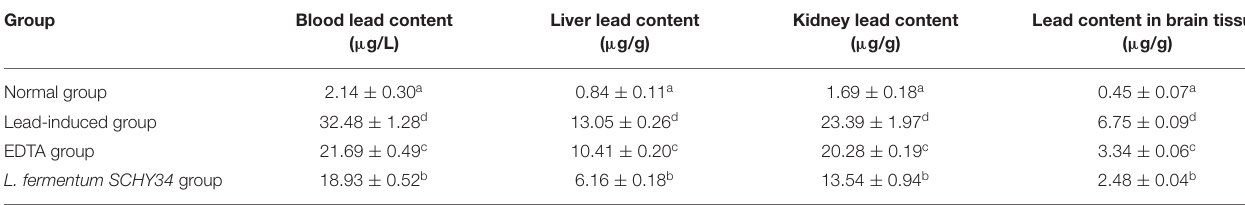
Liver lead content ( µ g/g)